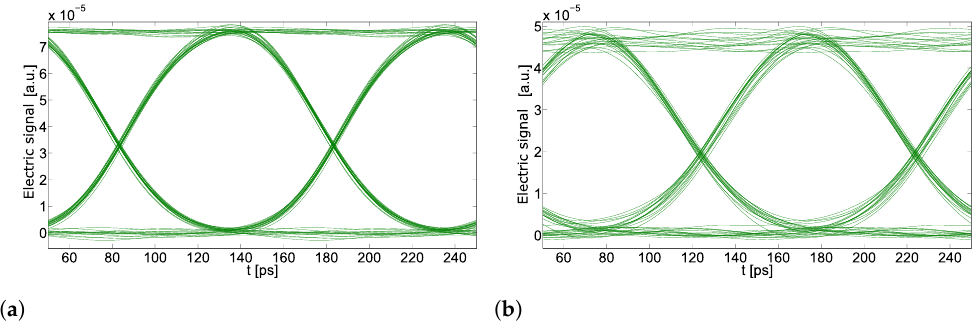
Figure 13. Eye diagrams for different PER settings-( a ) 30dB, ( b ) 15dB.